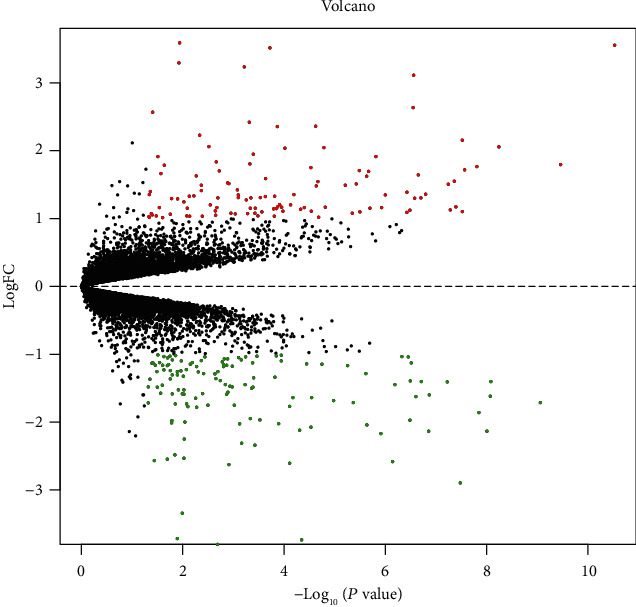
Volcano plot of DEGs between ENZ-R and ENZ-S PC cells. Red points represent upregulated genes, and green points represent downregulated genes. Genes without any significant difference are in black. The cutoffs for significant differences were ∣logFC | >2 and P < 0.05.